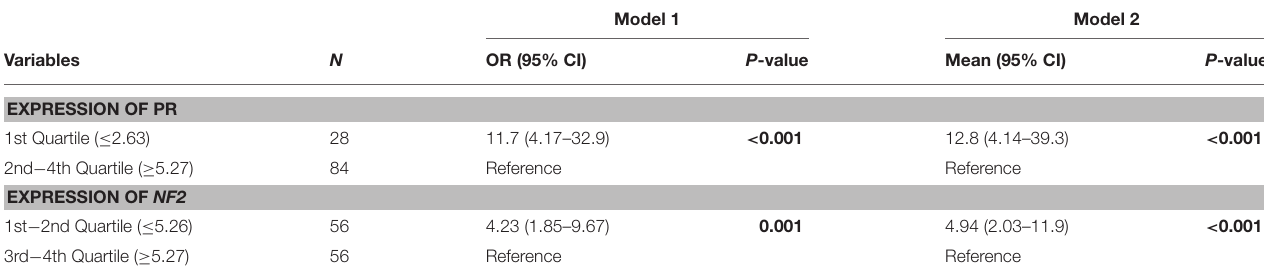
TABLE 3 | Associations of PR and NF2 expression with meningioma.